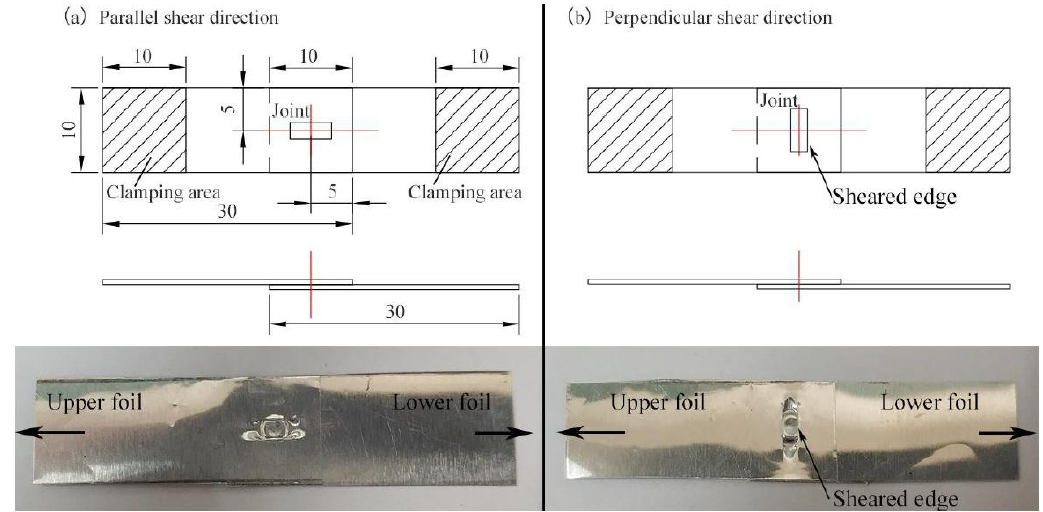
Figure 3. Dimensions and two shear directions of the single-lap shearing test sample.